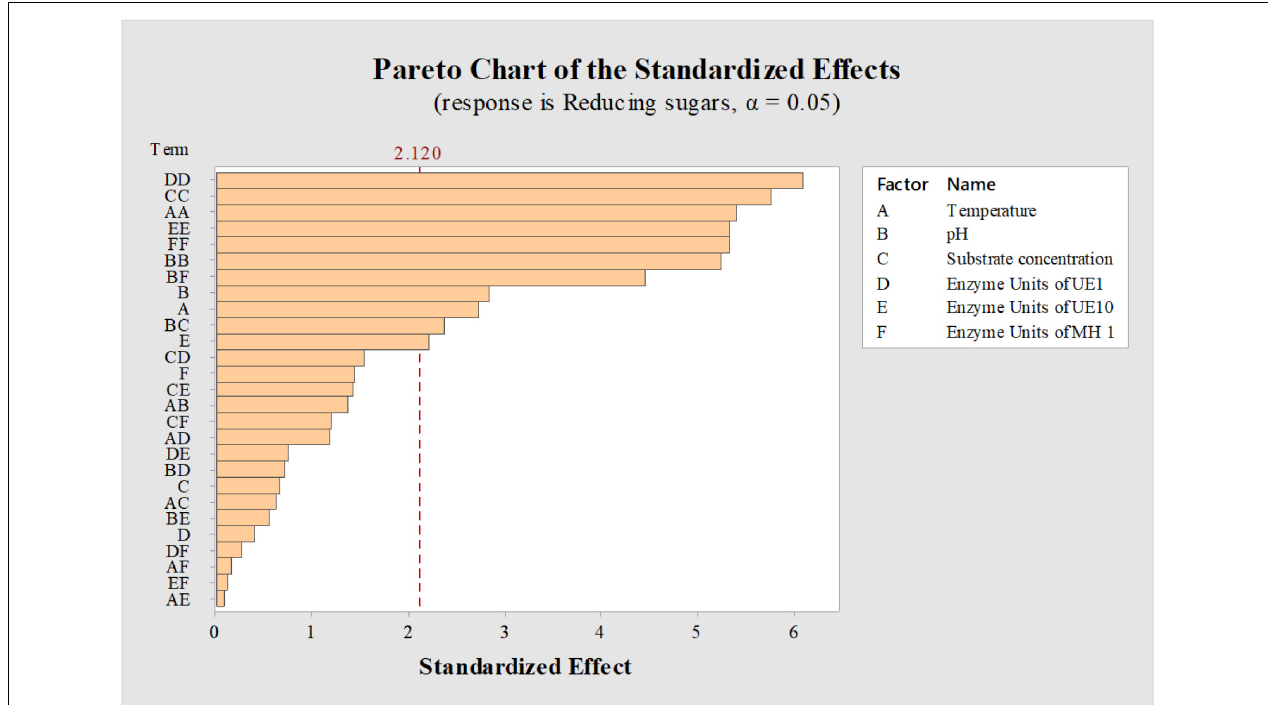
FIGURE 1 | Pareto charts showing the effect of factors on saccharification of acid-pretreated Phragmites karka. Dashed line indicates cumulative percentage.